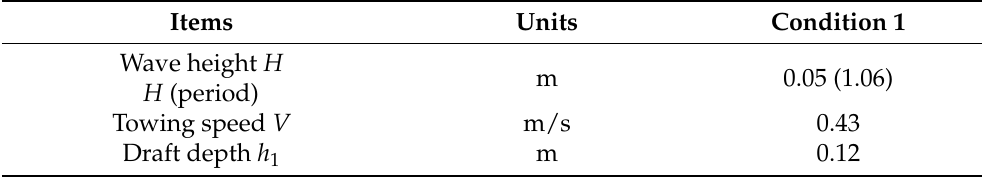
Table 4. Wet-towing conditions used in the test.